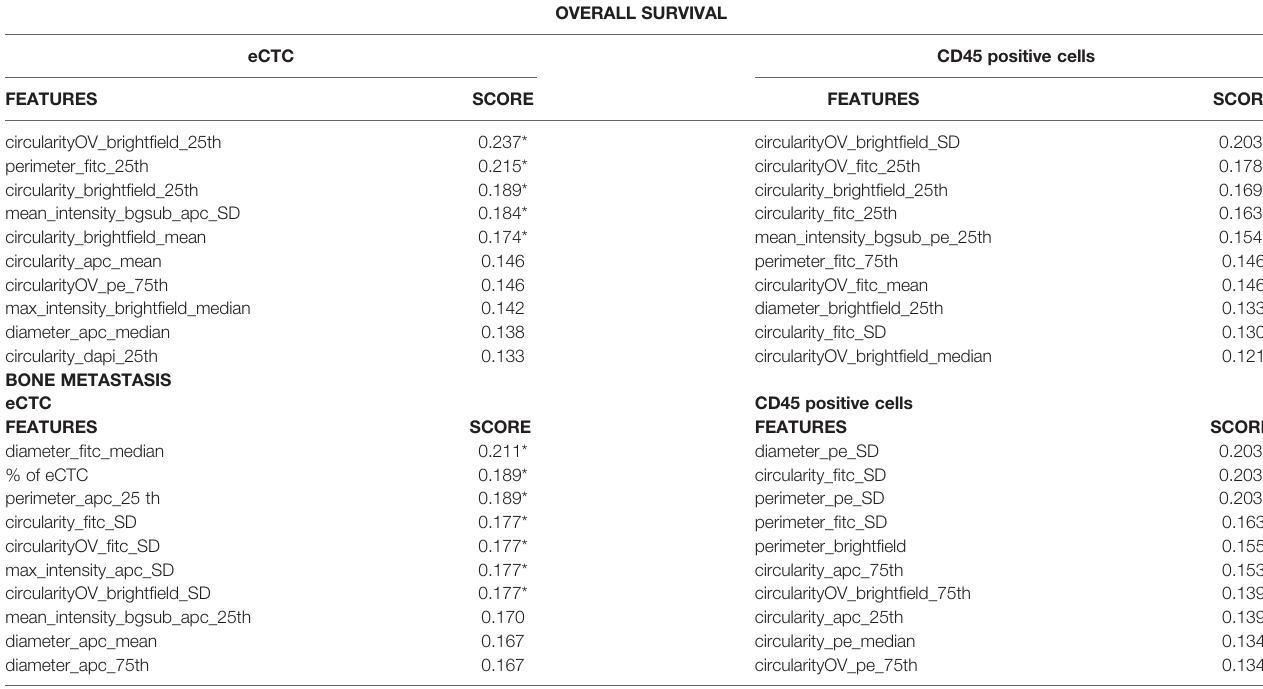
TABLE 3 | Best features ranked by information gain, with respect to overall survival and bone metastasis.